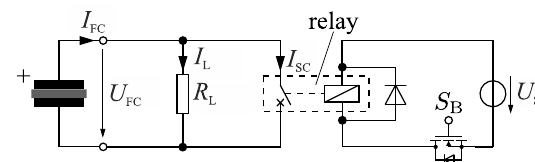
Figure 2. Experimental setup for external short-circuit (SC) tests